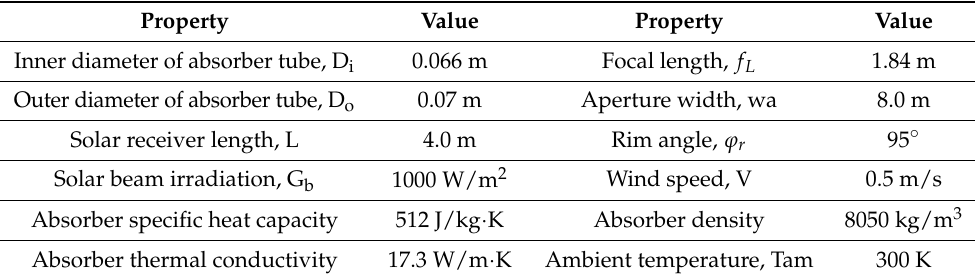
Table 2. The PTC model parameters used in the current work. Property